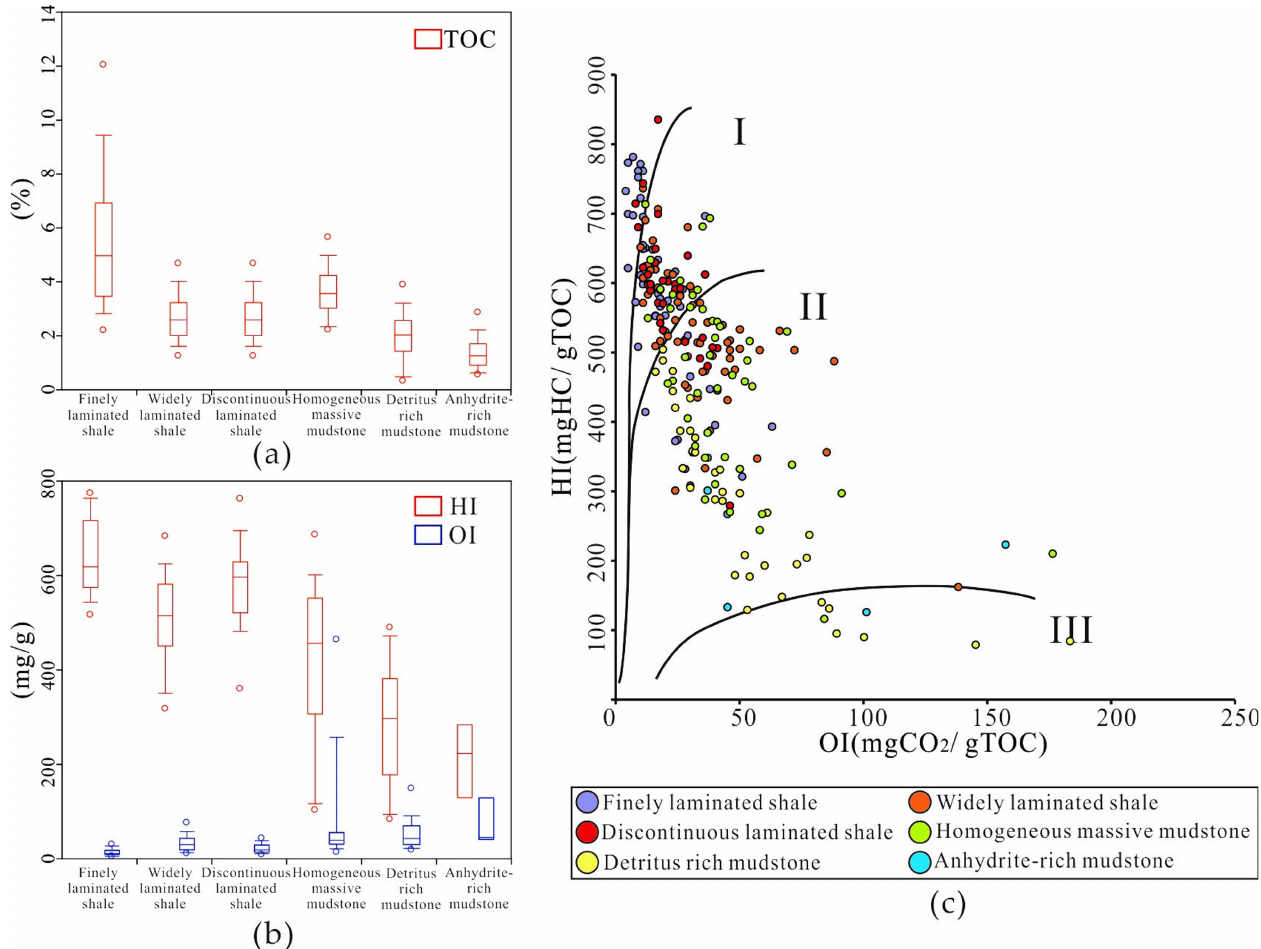
Figure 5. Pyrolysis characteristics of different lithofacies. ( a ) Box plots of the TOC values of different lithofacies. ( b ) Box plots of the HI and OI values of different lithofacies. ( c ) Kerogen characteristics of different